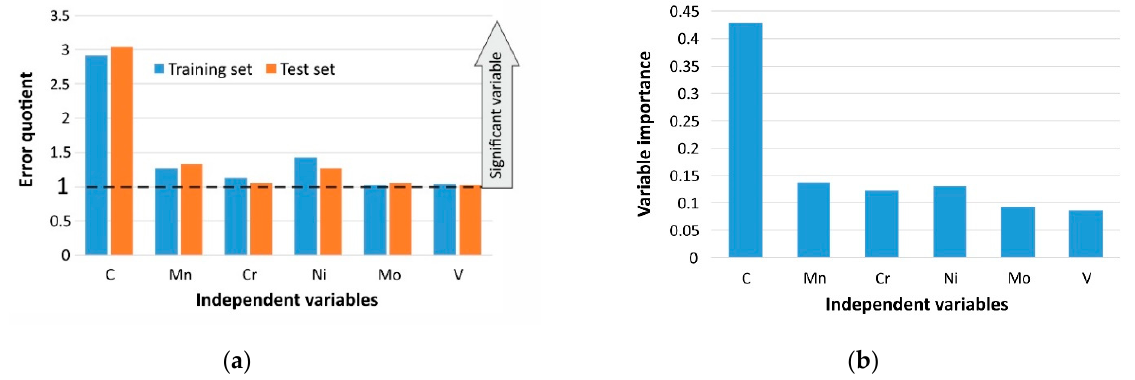
Figure 3. Examples of the sensitivity analysis used to evaluate the effects of independent variables on dependent variables based on the ( a ) error quotient and ( b ) relative importance of the input variables.